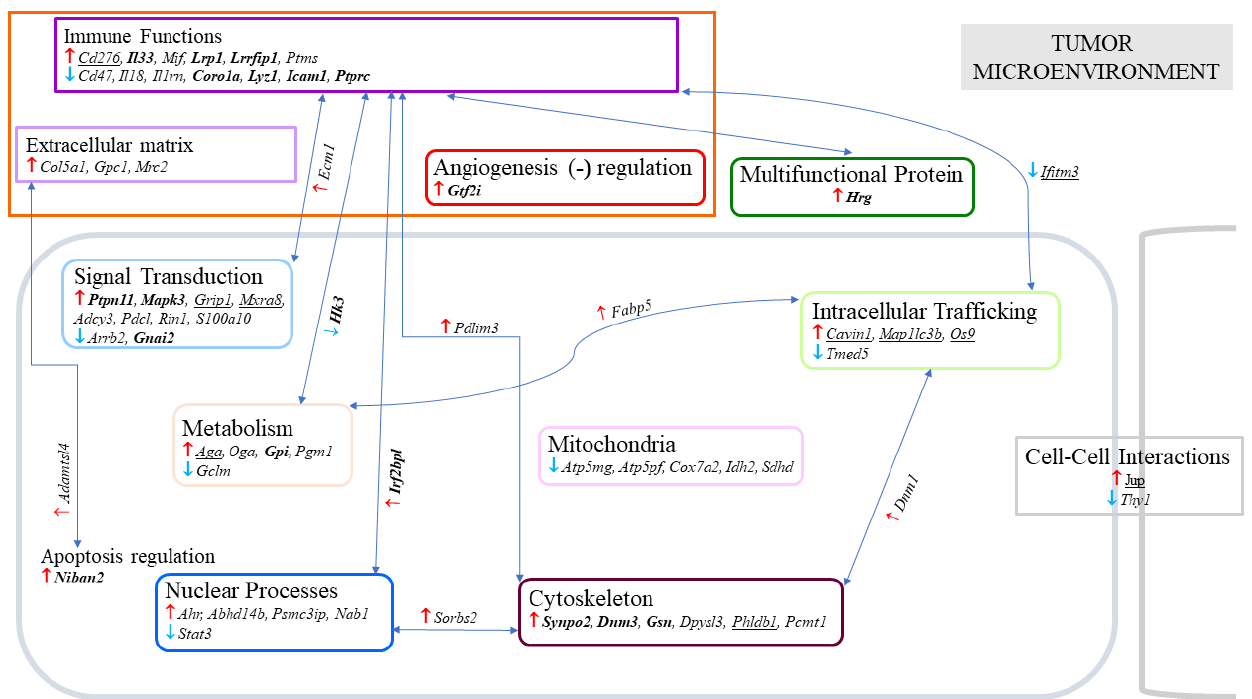
Figure 4. Main proteins exhibiting specific abundance changes related to multiple curcumin treatments. Proteins are identified by their encoding genes ( in italics ), with ↑ and ↓ symbolizing significant increase or decrease found in common in G3 vs. G1 and G3 vs. G2 and not found significant in G2 vs. G1. Underlined gene names correspond to p < 0.001 for the two conditions G3 vs. G1 and G3 vs. G2. Gene encoding proteins for which the evolution of abundance changes are shown in Figure 5 and are indicated in bold. Arrows between boxes symbolize proteins having multiple locations, as recorded on the website https://www.proteinatlas.org (accessed on 22 July